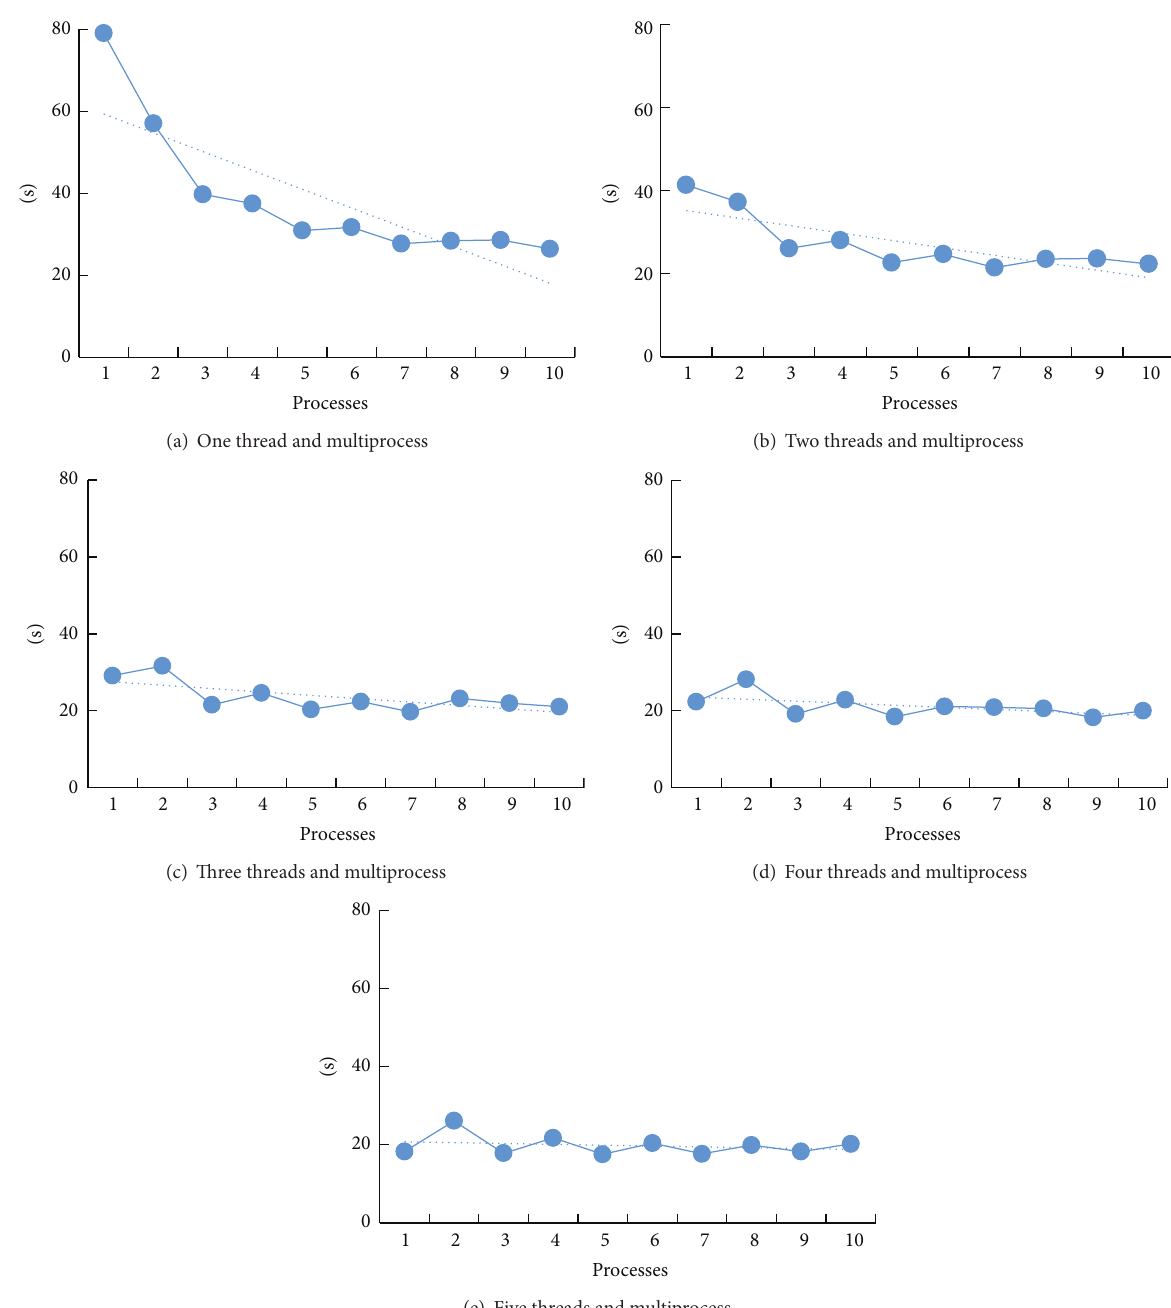
Figure 4: Algorithm speed and its relation to the number of processes and 1–5